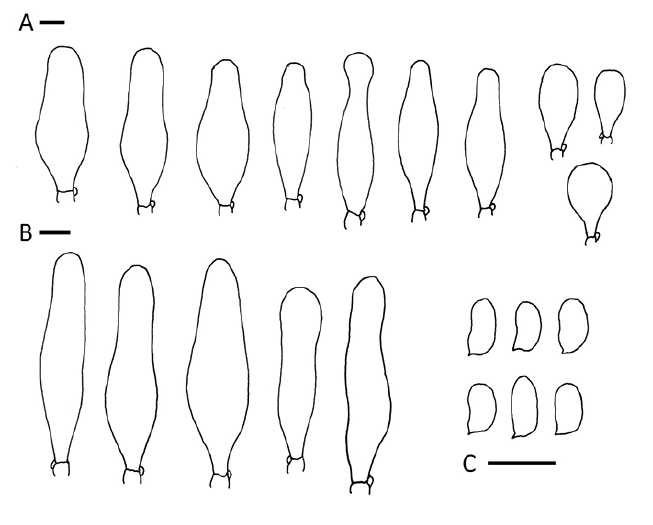
Figure 6 Microcharacters of Psathyrella larga (Kauffman) A. H. Sm.: ( A ) cheilocystidia; ( B ) pleurocystidia; ( C ) spores. Scale bars: 10 µ